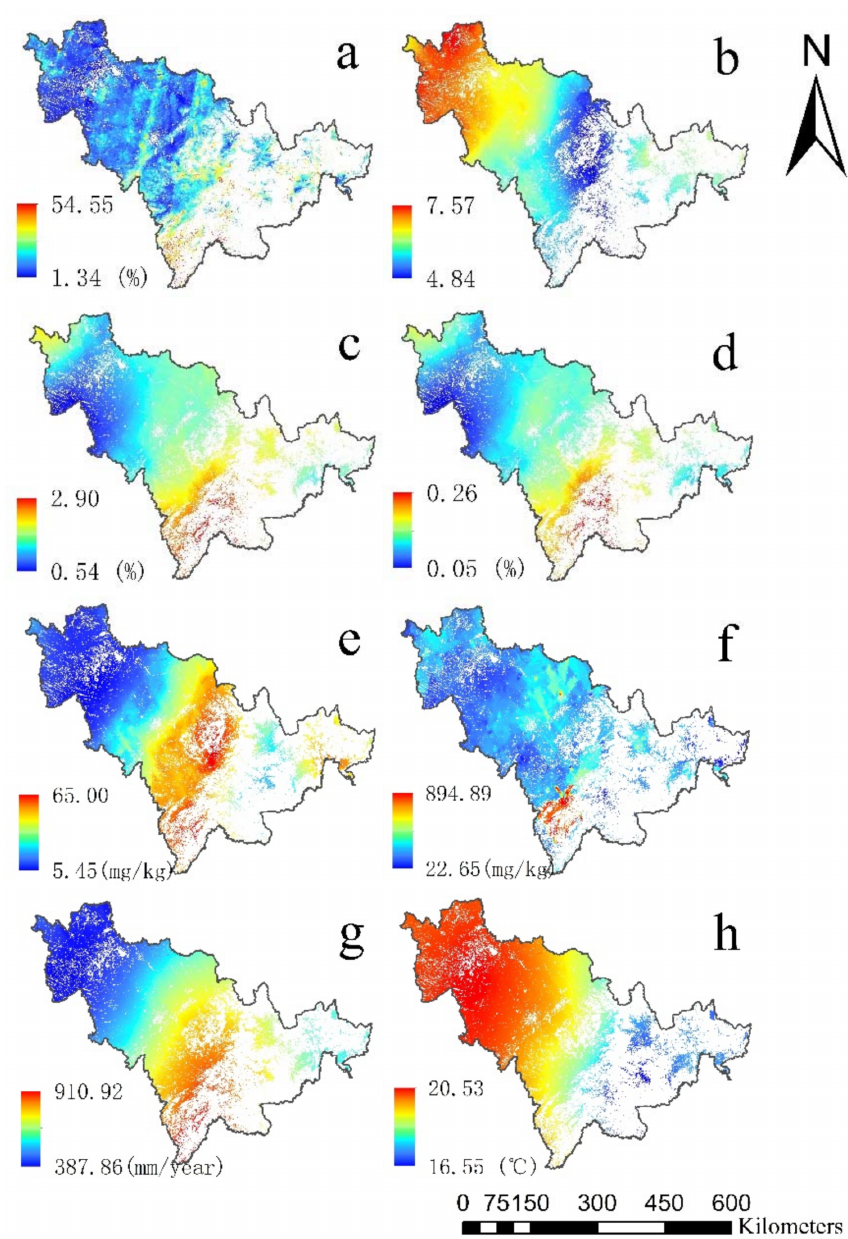
Figure 2. Interpolation map for the parameters influencing land suitability evaluation. ( a ) Slope; ( b